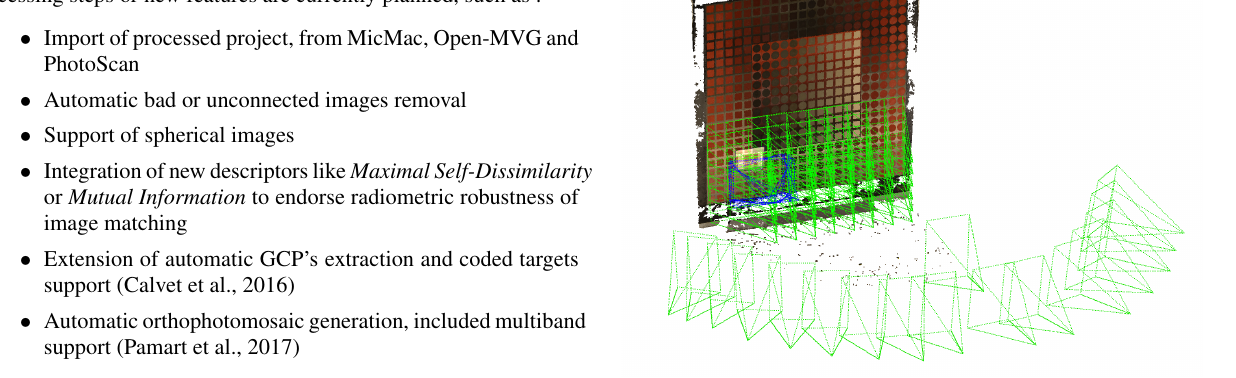
Figure 9: Data fusion with high scaling deviation Painting